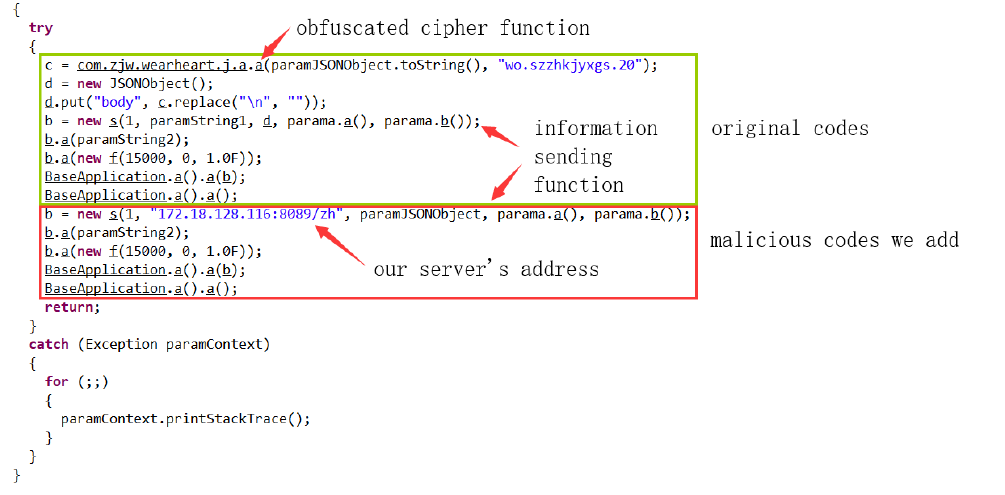
Figure 9. Malicious codes in Java